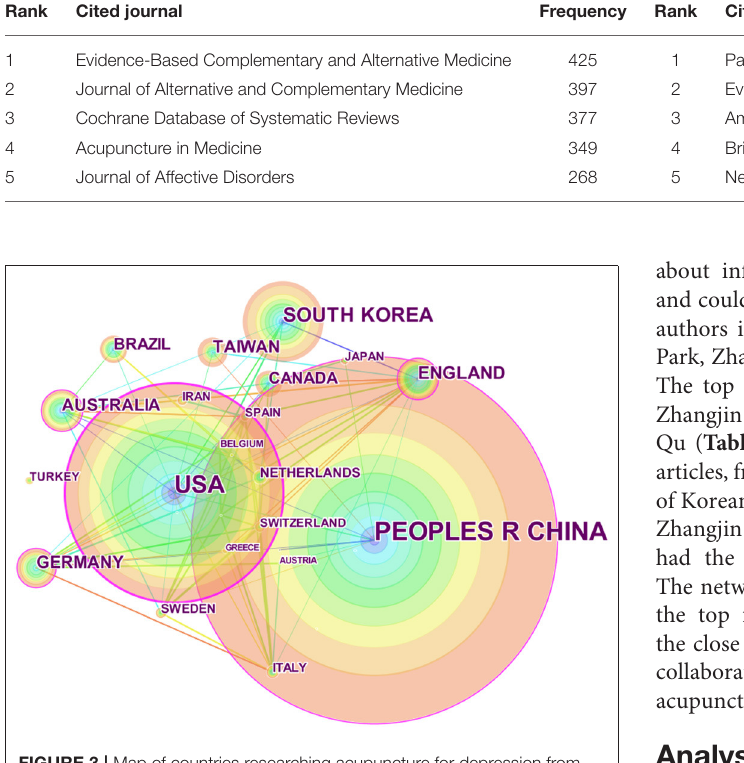
England, and Australia, researchers pay more attention to acupuncture as a specific treatment for depression ( Table 3